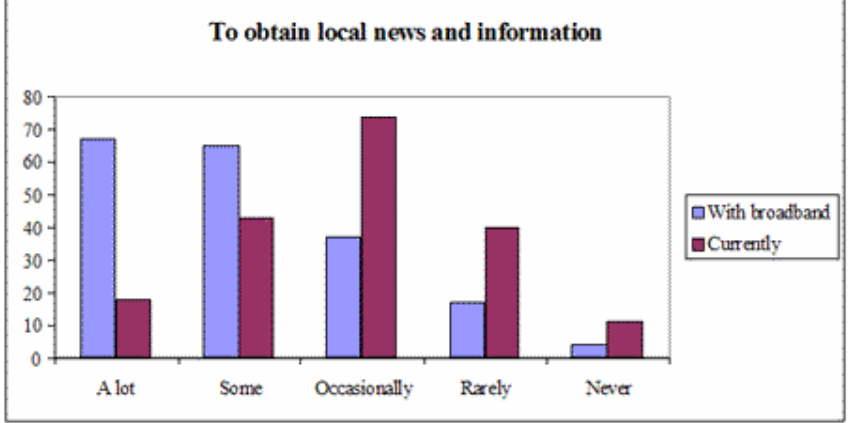
Figure 2. Respondents’ Current and Anticipated Use of the Internet to Obtain News and